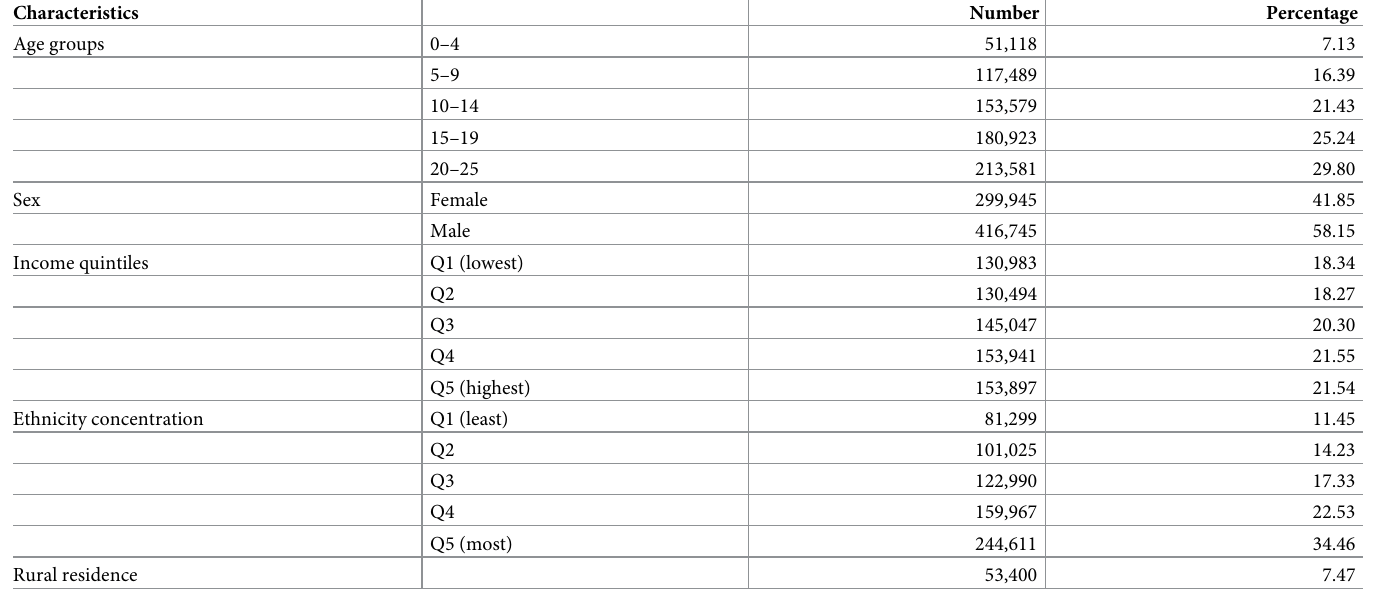
Table 1. Distribution of characteristics of the study population (N = 716,690).